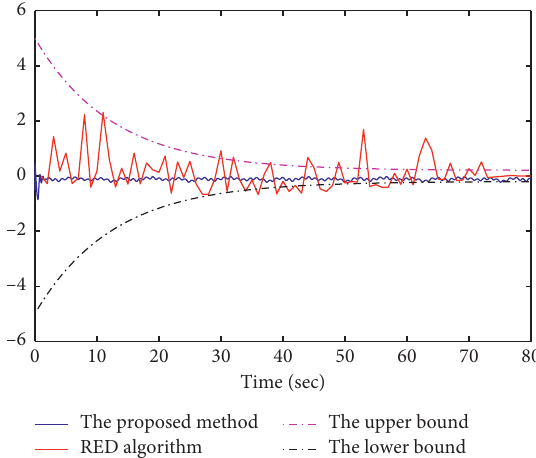
Figure 5: The sending rate r ( t ) .